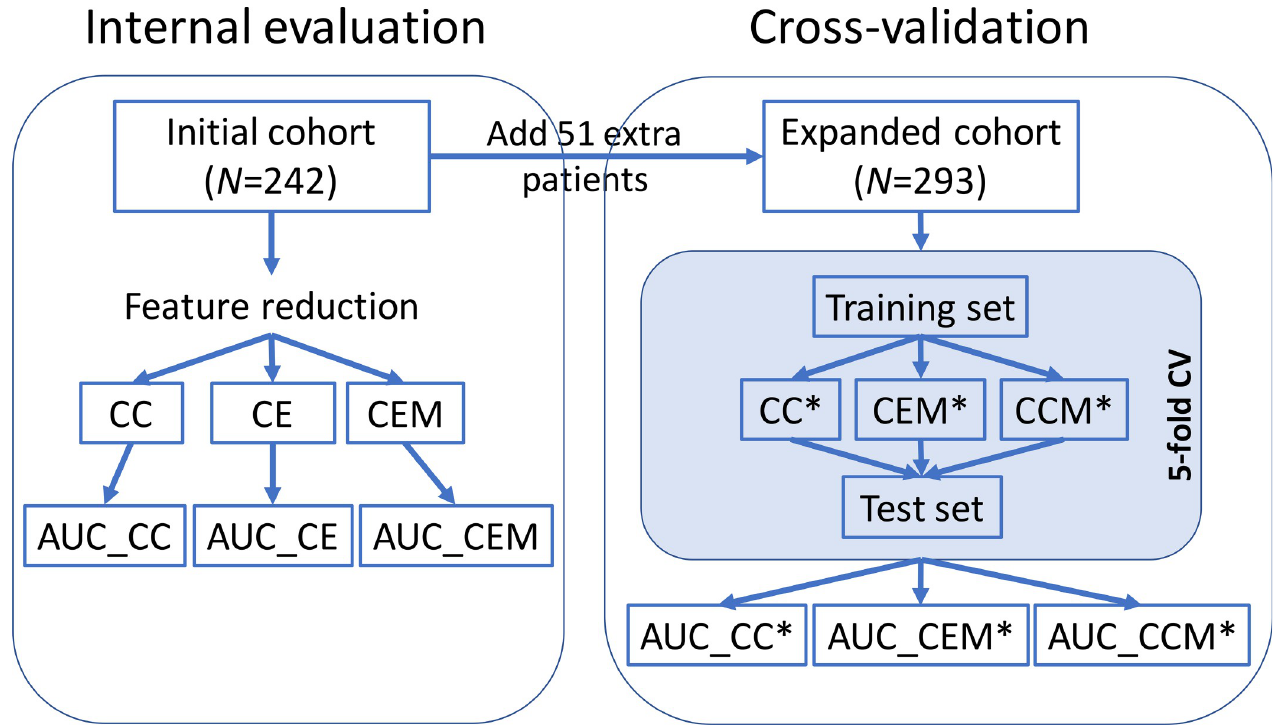
Fig 2. Study overview. A cohort of 242 patients were included in the internal evaluation phase according to the date of recruitment to the TAILORED-Treatment study. This cohort was used to compare the prediction performances of the classifiers using eCRF variables alone, as well as classifiers using both eCRF and microbiota variables (Internal evaluation phase). In the expanded cohort (51 extra patients), 5-fold cross-validation (CV) analysis was conducted to evaluate the contribution of eCRF and microbiota variables to prediction performance (Cross-validation phase). CC : C lassifier using C RP only in the initial cohort. CE : C lassifiers using two or more e CRF variables (incl. CRP) in the initial cohort. CEM : C lassifiers using all input e CRF variables (incl. CRP) and at least one m icrobiota in the initial cohort. CC � : C lassifier using C RP only in the 5-fold CV of the expanded cohort. CEM � : C lassifiers using two or more variables (regardless e CRF or m icrobiota) in the 5-fold CV of the expanded cohort. CCM � : C lassifiers using C RP and all input m icrobiota variables in the 5-fold CV of the expanded cohort. AUC: Area Under the ROC